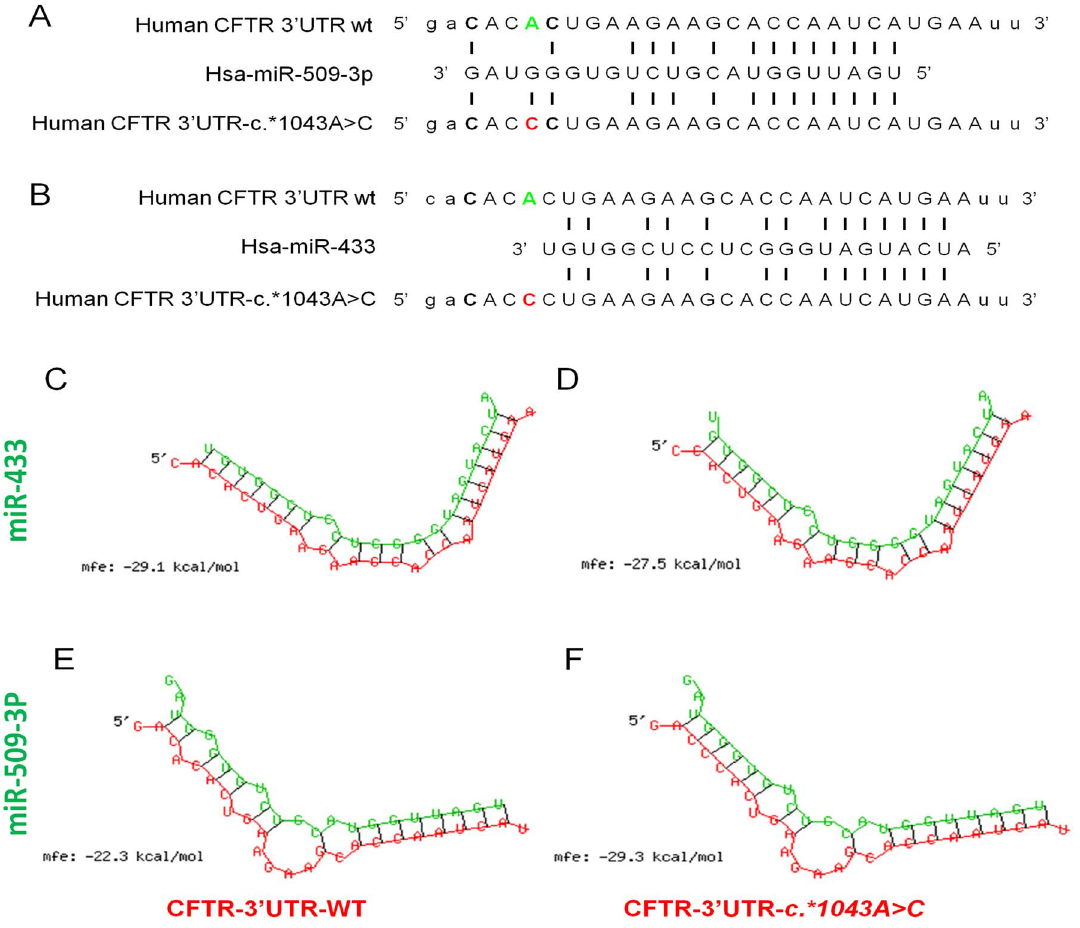
Figure 1. Bioinformatics prediction of c*1043A . C mutation position and effect on miRNA affinity. A–B) schematic diagram of the two in silico predicted miRNAs aligned with either wild-type (in green) or c.*1043A . C (in red) mutation of CFTR 3 9 UTR. C–D) predicted wild-type or CFTR 3 9 UTR-c.*1043A . C mutation Hybrid structure with miR-433. E–F) predicted wild-type or CFTR 3 9 UTR-c.*1043A . C mutaion Hybrid structure with miR- 509-3p, for each hybrid structure is shown the mean free energy (mfe) calculated using the RNAHybrid server.